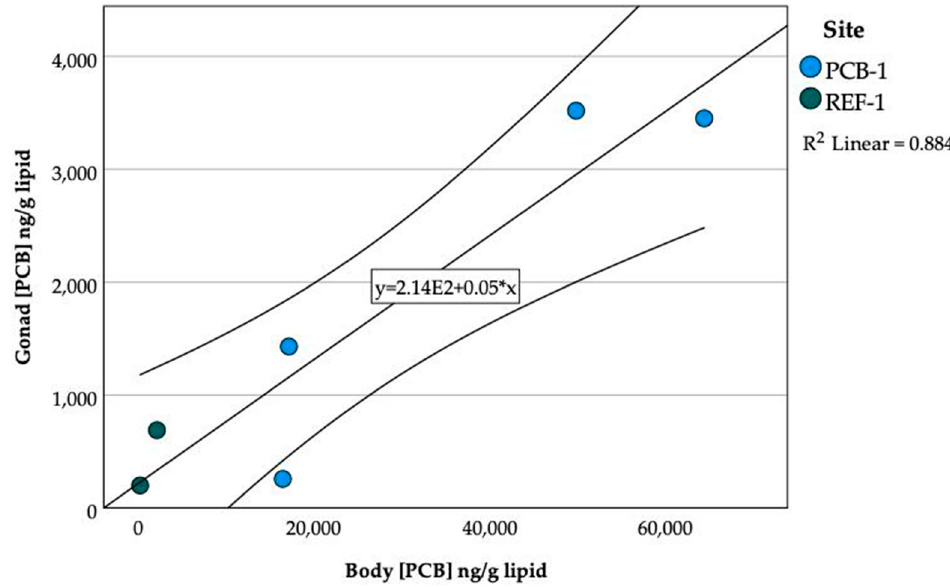
Figure 7. Relationship between lipid normalized PCB concentrations found in the gonad and in the body tissues of damselfish from PCB-1 and REF-1, Johnston Atoll. Linear regression with 95% mean prediction interval.